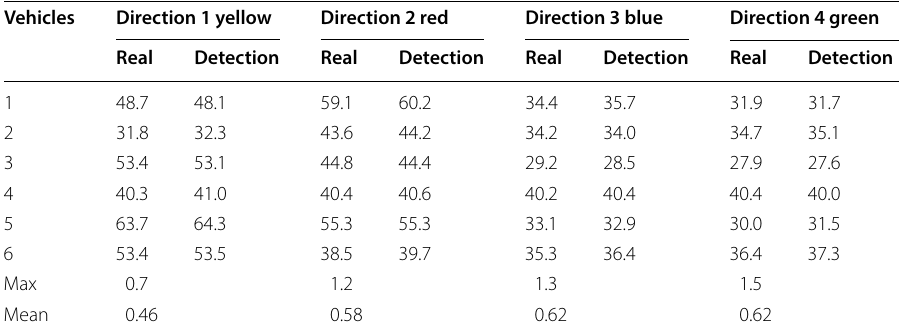
Table 5 The experimental results of the speed detection system Vehicles